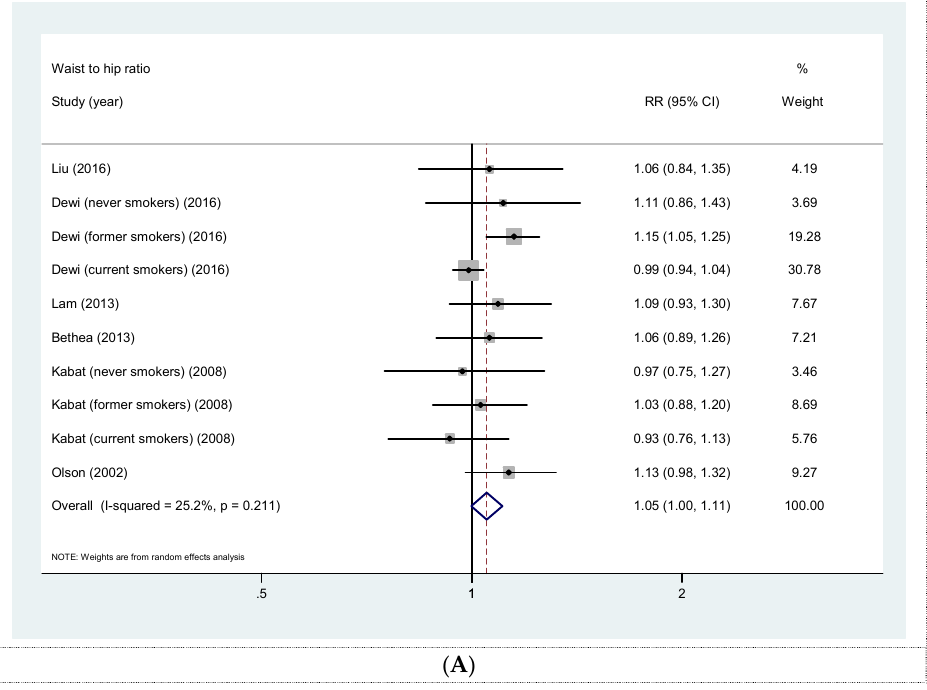
( A ) Figure 3. Cont